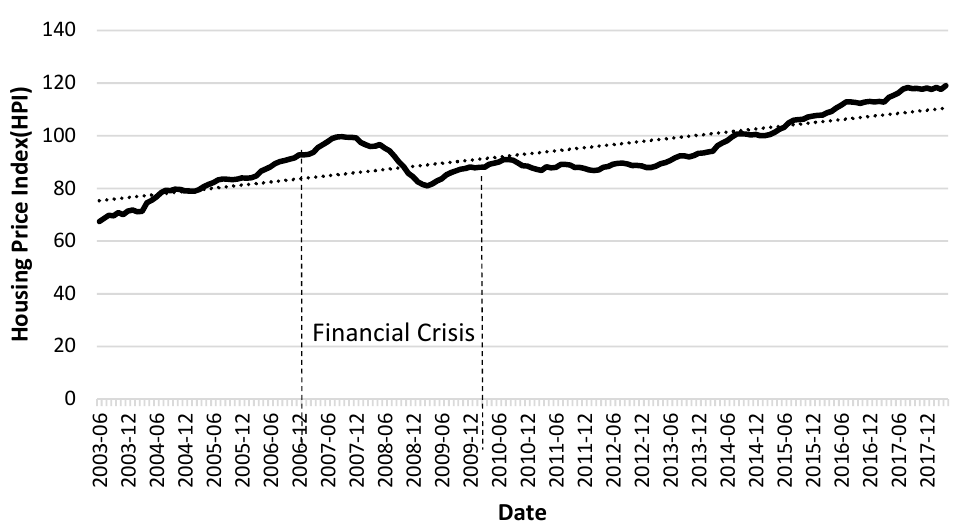
Figure 4. Montly HPI index for the United Kingdom, January 2005–December 2017, (2005 = 100). ONS, UK.